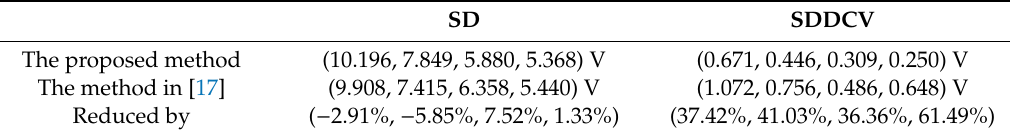
Table 5. Statistical result of Figure 5.